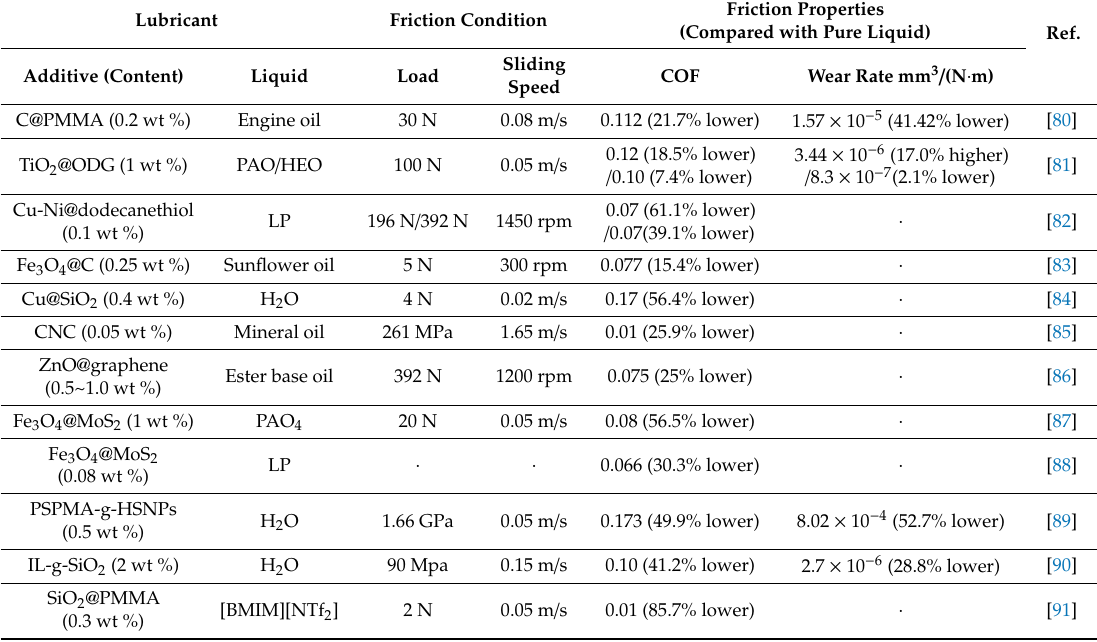
Table 3. Parameters of additives in liquid lubricants. Lubricant Friction Condition